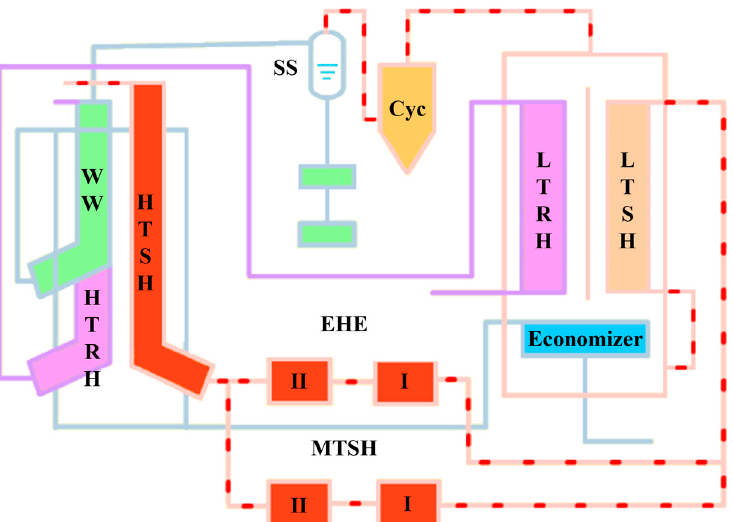
Figure 2. Schematic of steam and water flow circuit of typical ultra-supercritical CFB boiler. LT: low-temperature, MT: medium-temperature, HT: high-temperature, WW: water wall, SS: steam separator, SH: superheater, RH: reheater.